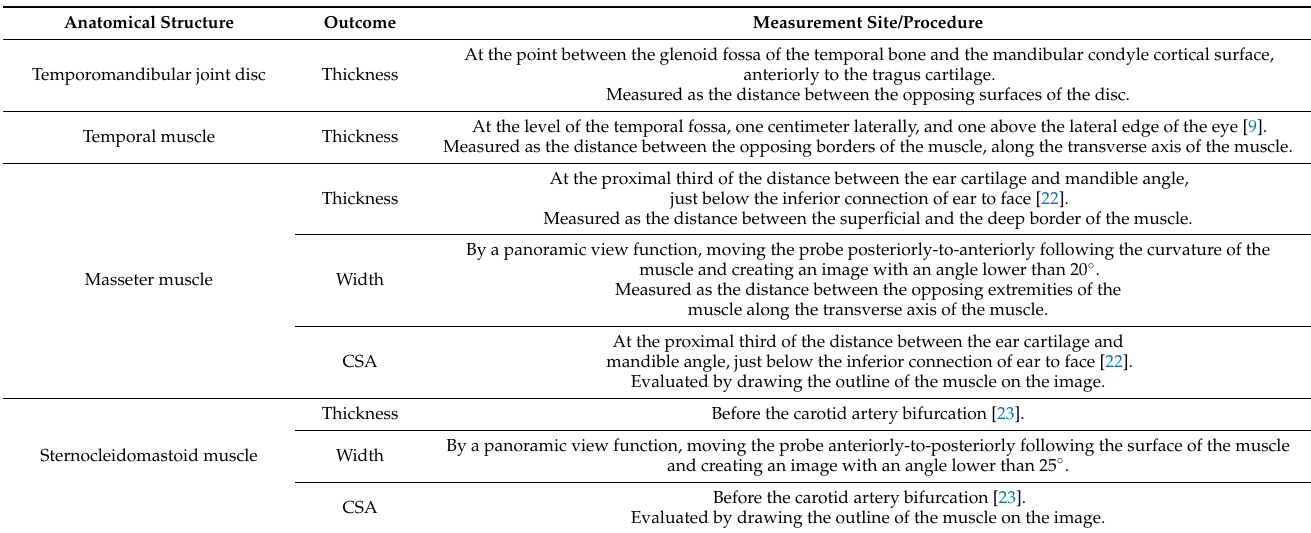
Table 1. Ultrasonographic outcomes and measurement